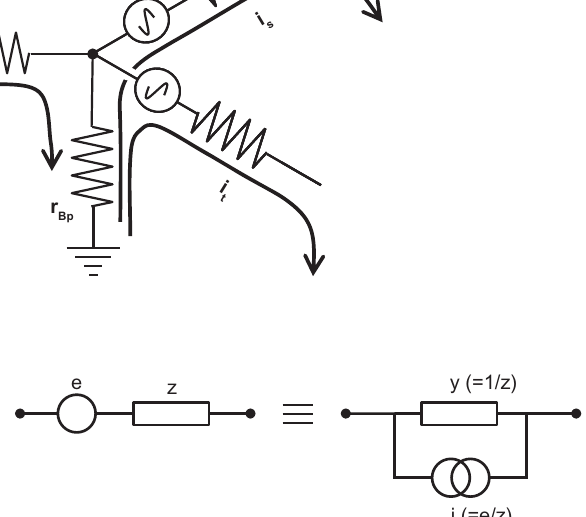
Fig. 3. Equivalence of series voltage source and parallel current